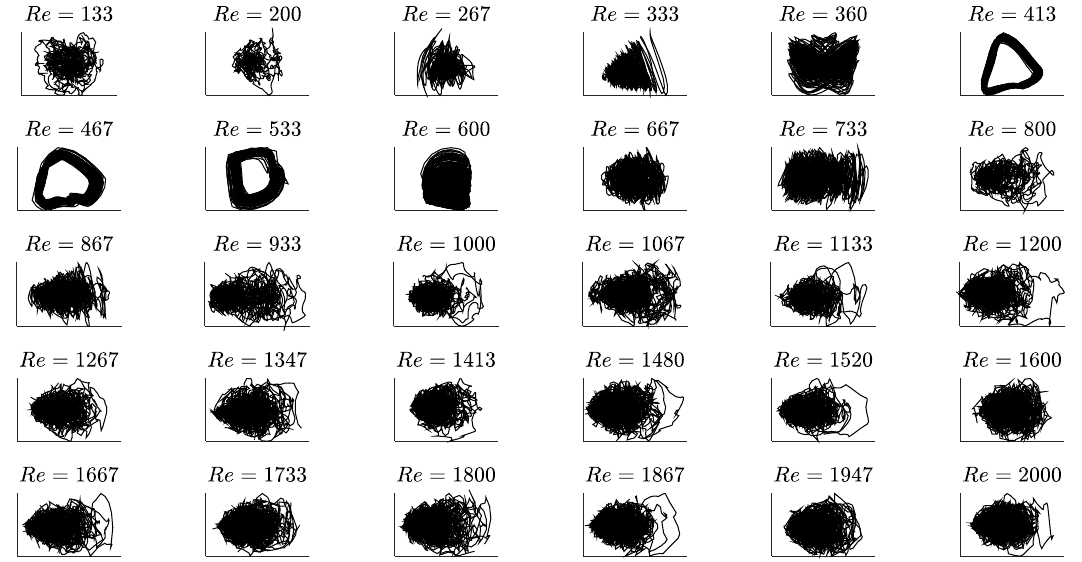
Figure 8. Autocorrelation function of the total displacement of the free-end of Filament 1 at different Reynolds number values (the x -axis scale is in seconds).